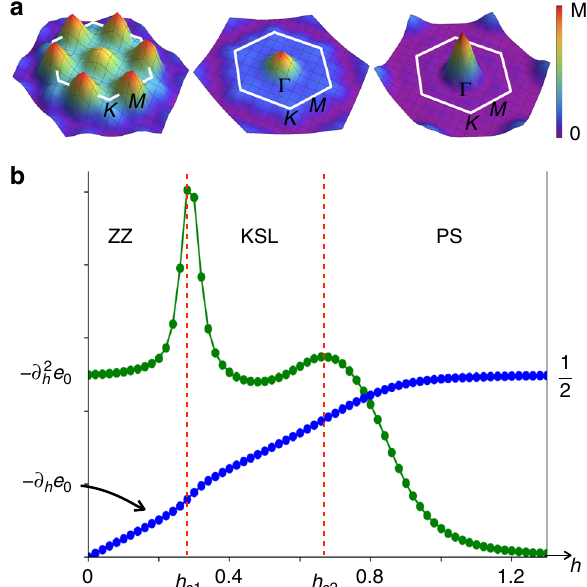
Fig. 2 Sequence of phases in a magnetic fi eld. a Spin structure factor S ( q ) within the ZZ, KSL, and PS phases. b χ h ¼ (cid:4) ∂ 2 h e 0 and magnetization m = − ∂ e fi eld are shown for a fi xed Γ / K ≃ − 0.37, h 0 as a function of a 5° tilted indicated by a green dashed line in Fig. 1b. The fi eld strengths h c1 and h c2 are the critical values at which the transitions from the ZZ to KSL, and the KSL to PS occur,